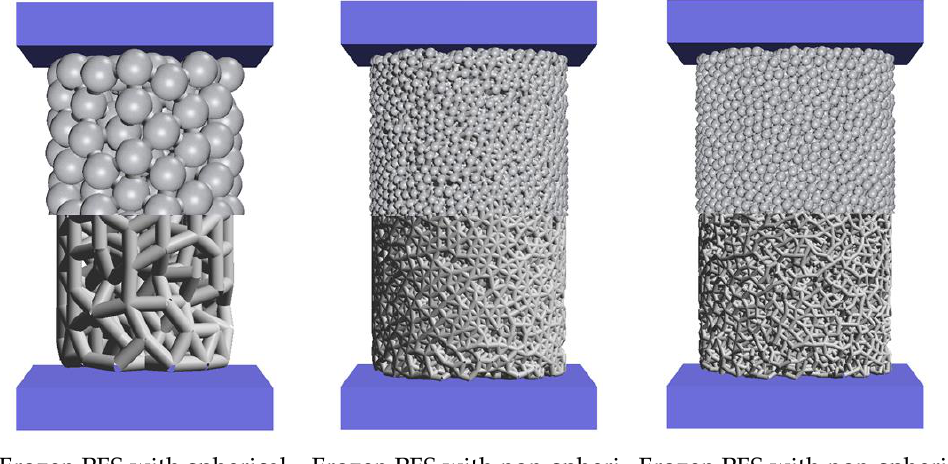
Figure 9. Representative agglomerate with diameter 10 mm, height 16 mm ( upper part: agglomerates in complete form; lower part: agglomerates ’ internal structure).